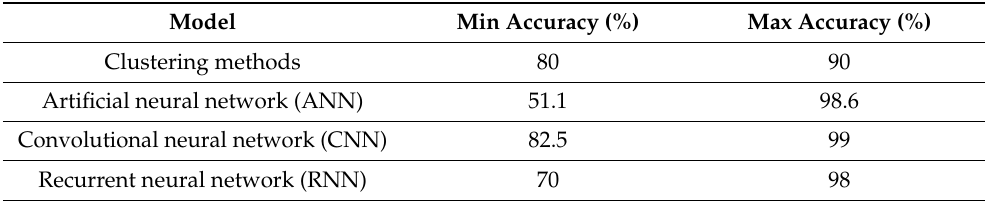
Table 7. Performance of different Machine Learning-based models for Acoustic Emission